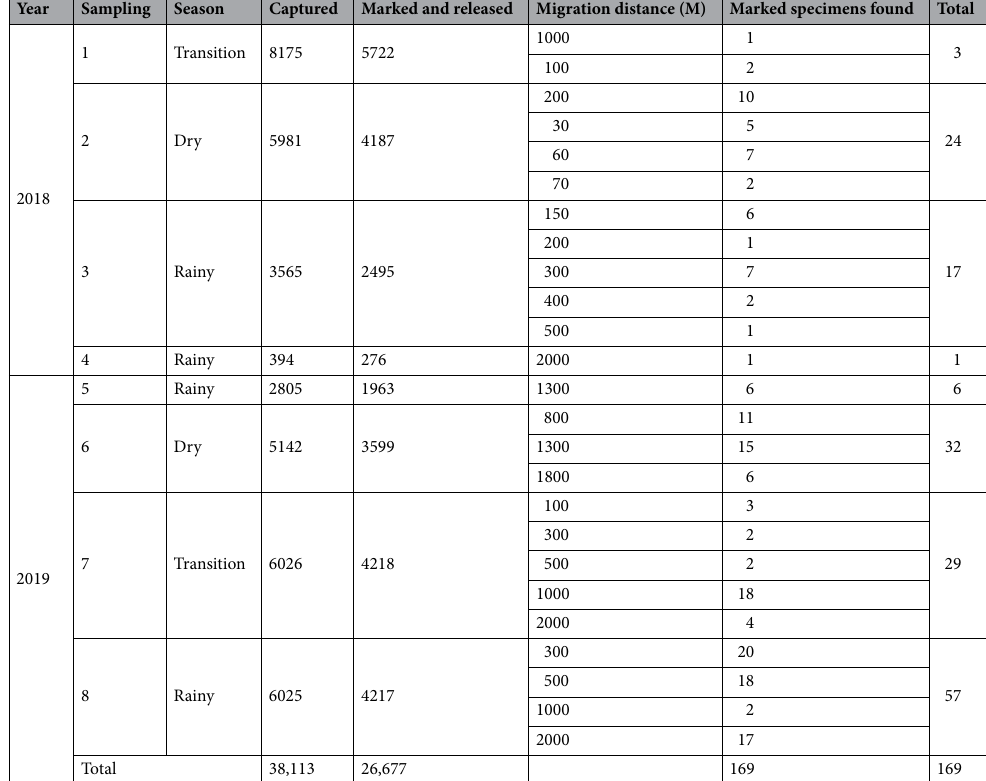
Table 1. Distribution of the number of estimated specimens captured, marked, released, and recaptured in the surrounding area of the Amazon Jirau (HPP-Jirau) hydroelectric power plant, Rondônia state, Brazil, from 2018 to 2019.